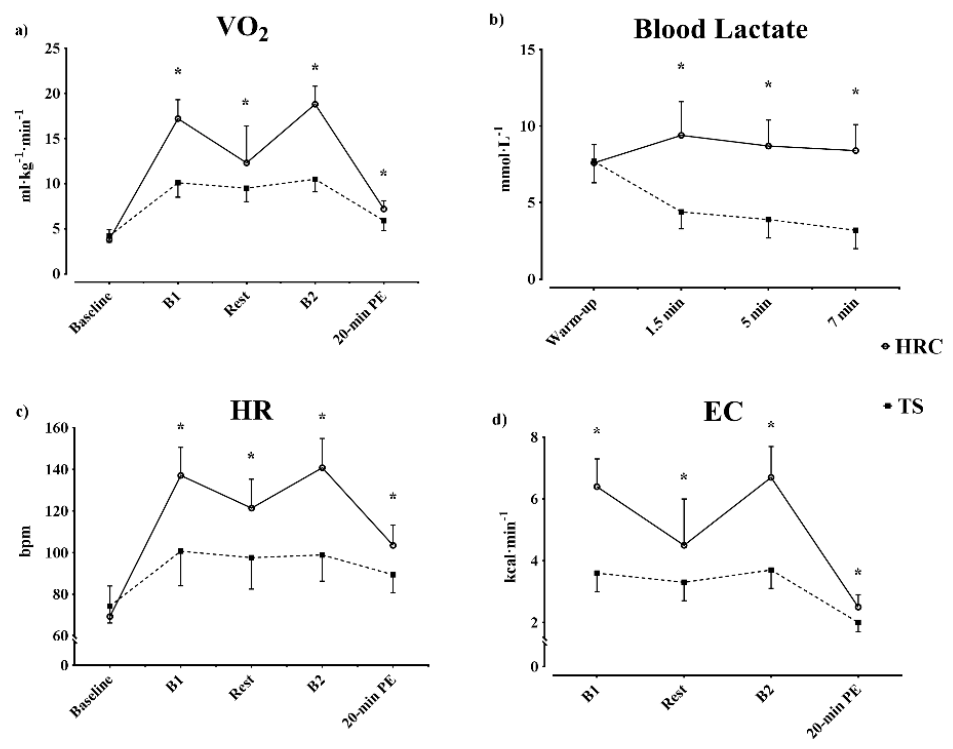
Figure 2. Oxygen consumption, blood lactate, heart rate, and energy cost, during HRC training or TS training and mean in the final rest period. ( a ); oxygen consumption; ( b ); blood lactate concentration; ( c ); heart rate; ( d ); energy cost; HRC = high-intensity resistance circuit-based training; TS = traditional strength training; VO 2 / BM = relative oxygen consumption; HR = heart rate; B1 = block 1; B2 = block 2; average = mean of B1 and B2. * = significant differences from HRC, p < 0.001.